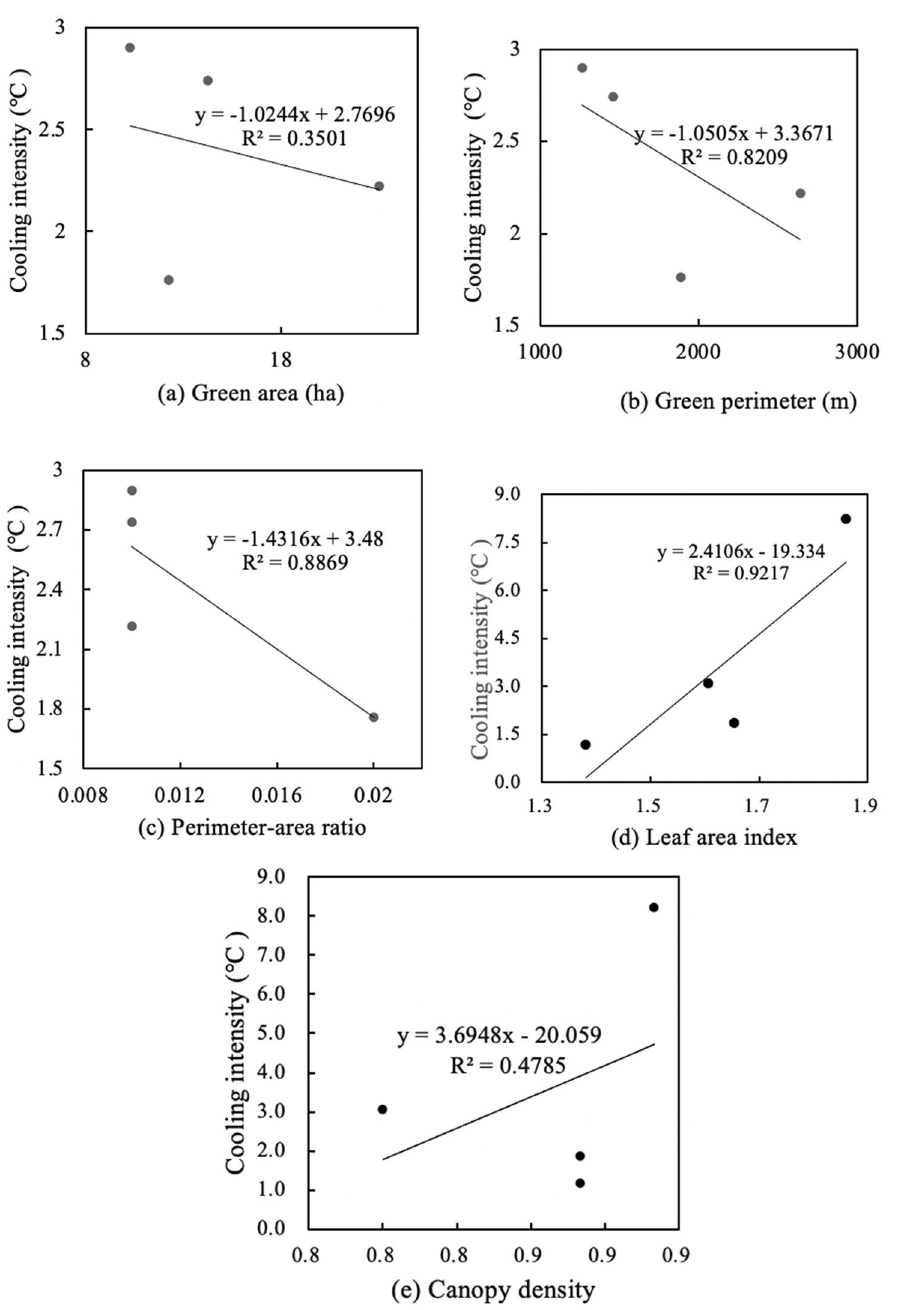
Figure 10. Linear regressions of spatial characteristics and cooling intensity of large-size green